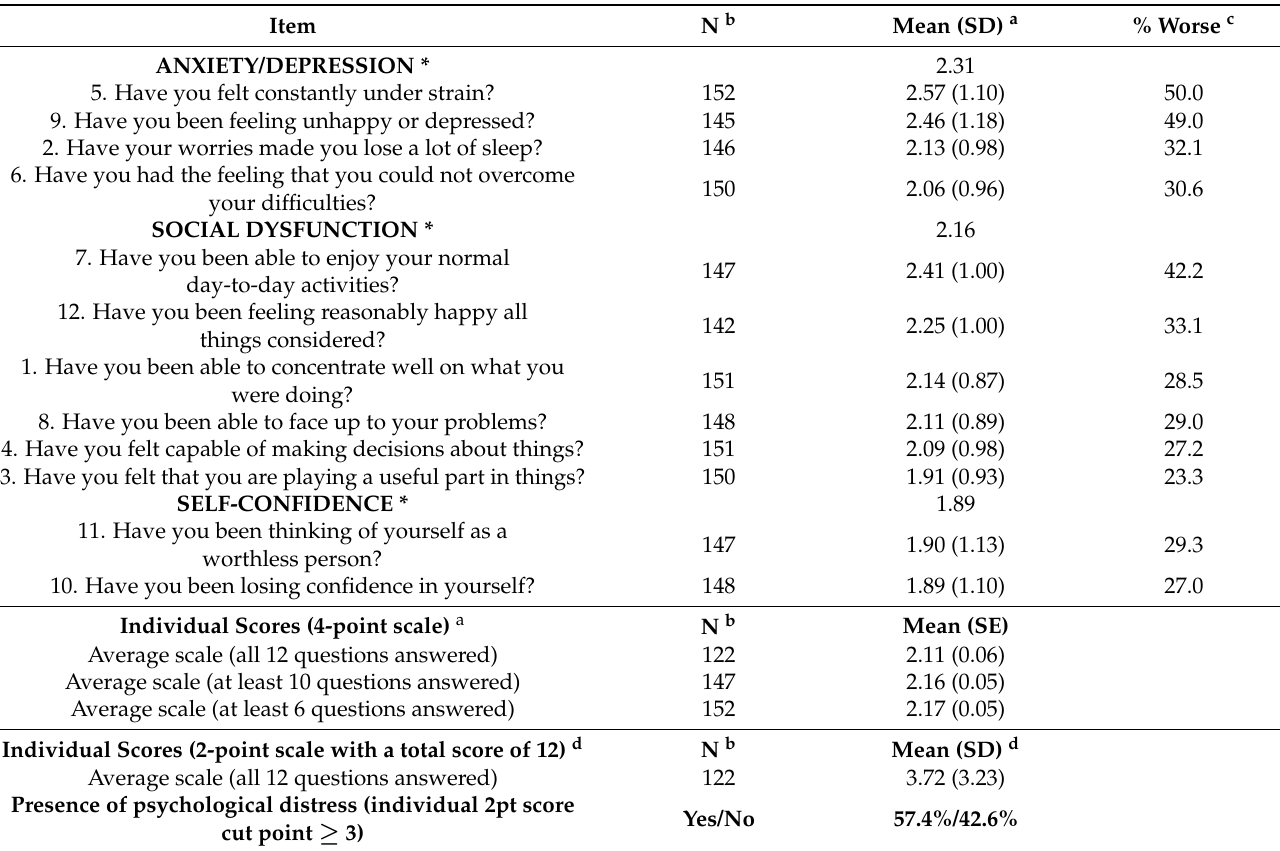
Table 2. General Health Questionnaire